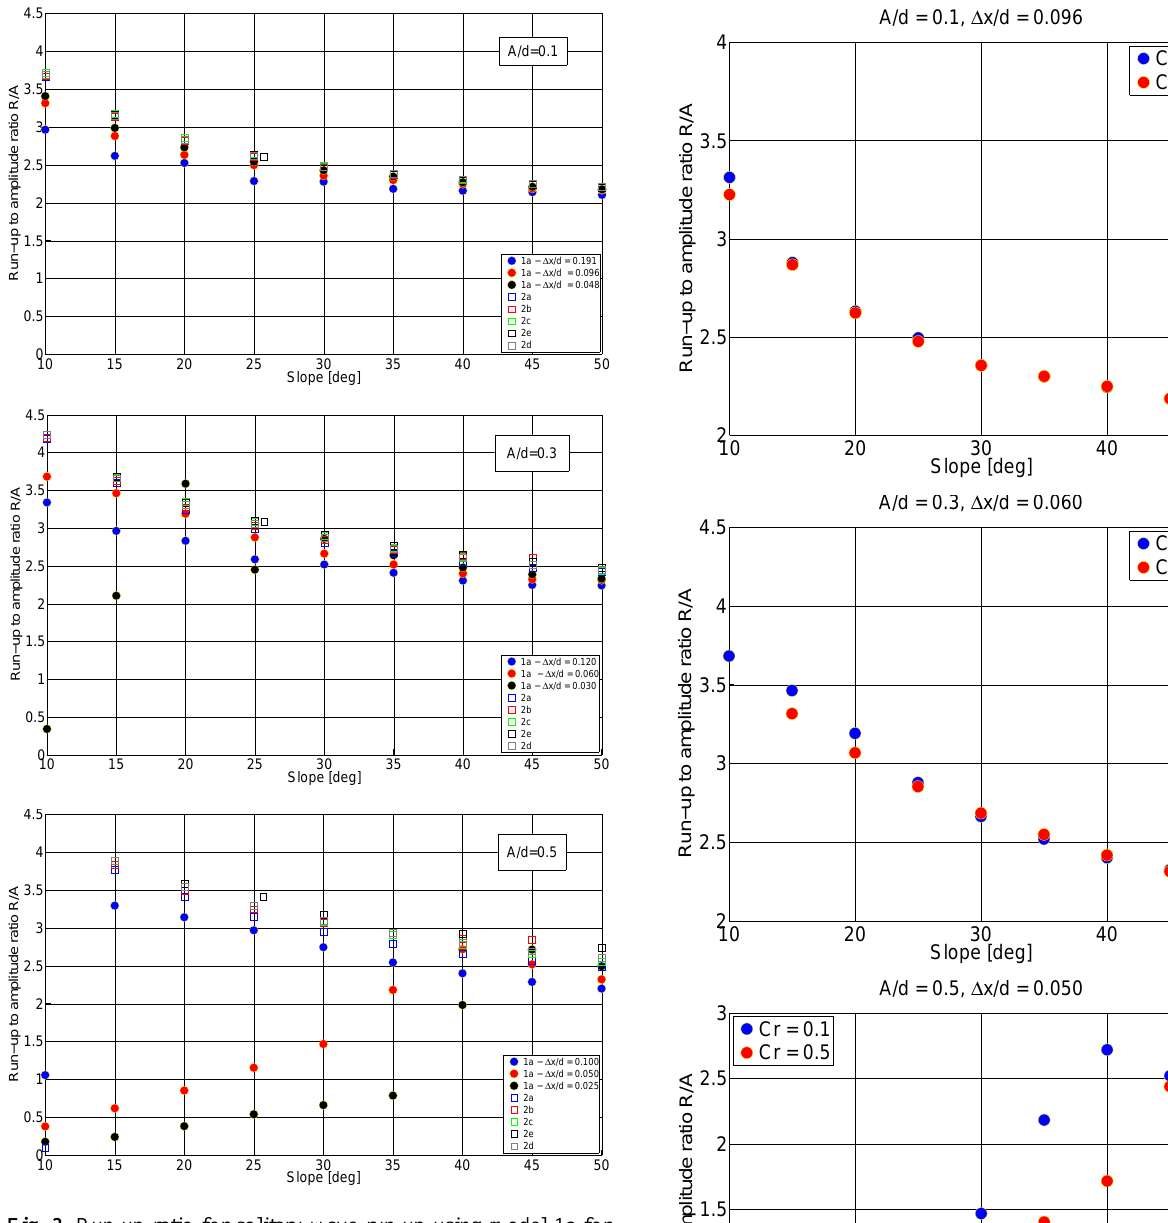
Fig. 3. Run-up ratio for solitary wave run-up using model 1a for different slopes, initial amplitudes, and grid resolutions. Here, a Courant number of Cr = 0 . 1 is employed. Results with Lagrangian models are included for comparison. Upper panel, A/d = 0 . 1, mid panel A/d = 0 . 3, lower panel A/d = 0 . 5. The drop in the run-up ratio for the largest amplitudes in combination with gentlest slope is due to model breakdown.